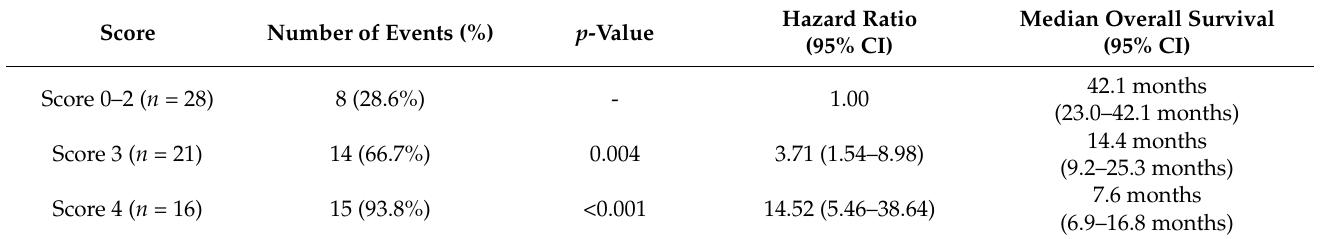
Table 4. Comparison of overall survival according to the PET/CT scoring system.